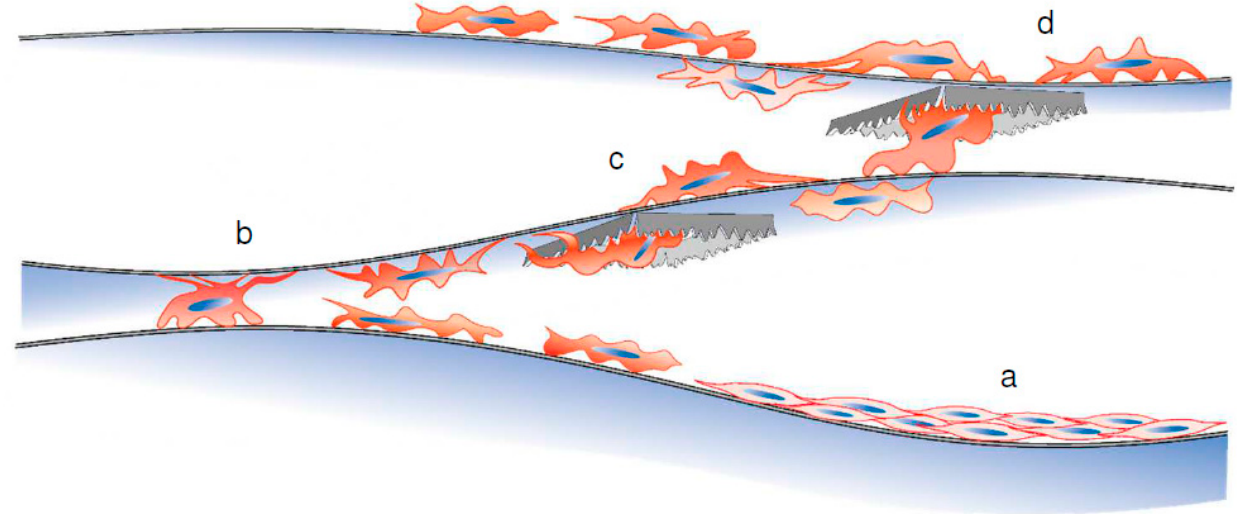
Figure 9. The schema of cell proliferation in the multi ‐ layered Ti membrane. The C3H10T1/2 cells seeded on the original membrane (layer “±0”) grew in the space between layers “±0” and “+1” ( a ). The cells climbed to layer “+1” at the contact point between the layers “±0” and “+1” ( b ). The cells divided and expanded around layer “+1” and migrated to the opposite side of the membrane via nano ‐ sized pathways ( c ). The cells rose to layer “+2” at the contact point between the layers “+1” and “+2” ( d ). The burrs around the pores did not interrupt cell migration to the upper layer.